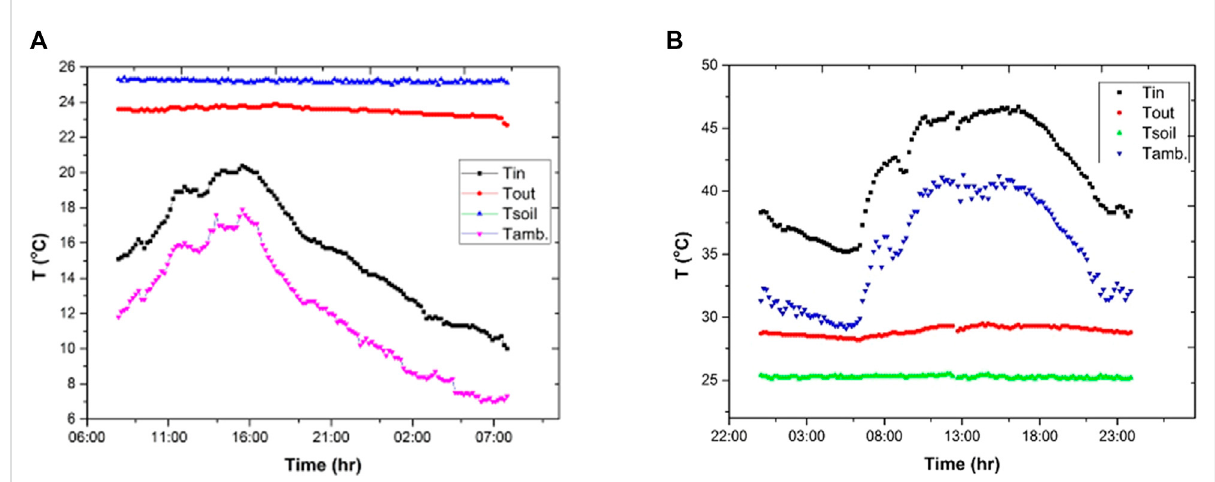
FIGURE 7 Variation of temperature with time during (A) January and (B) June.